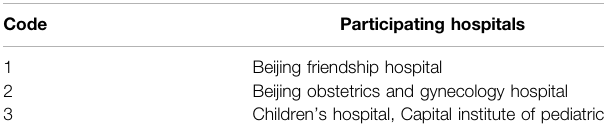
TABLE 1 | Hospitals participating in this